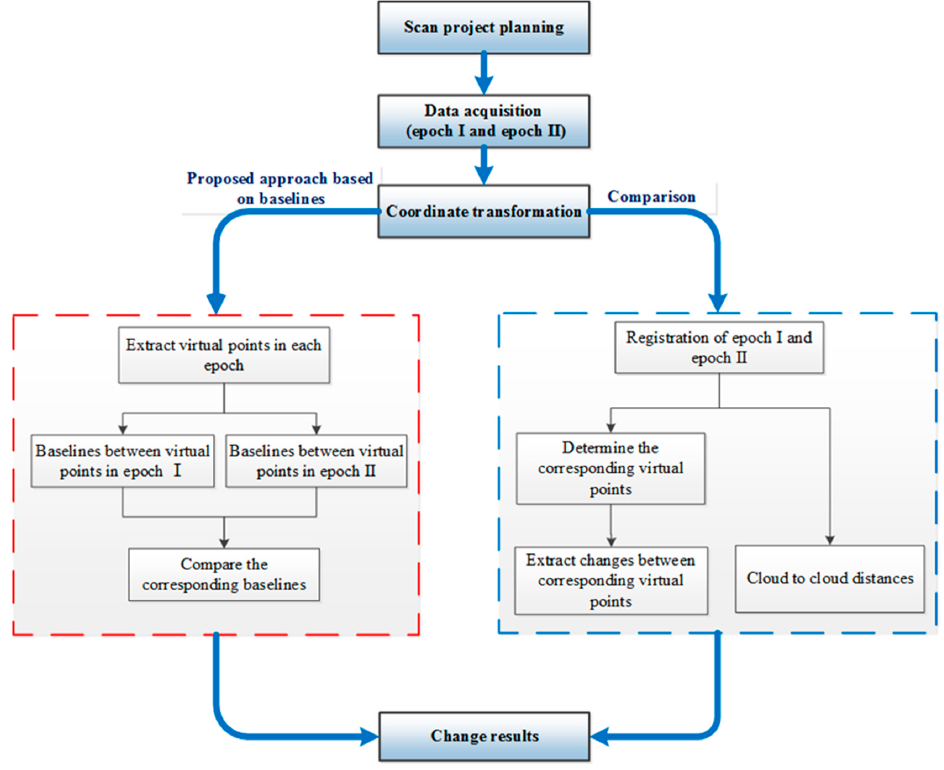
Figure 1. Change detection workflow.